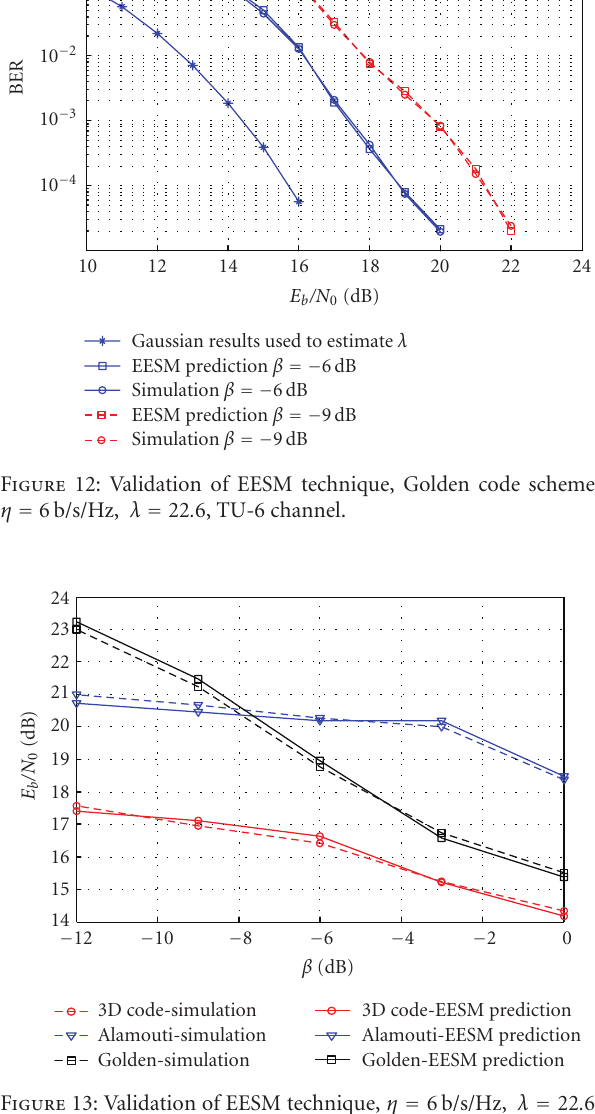
Figure 13: Validation of EESM technique, η = 6 b/s/Hz, λ = 22 . 6, TU-6